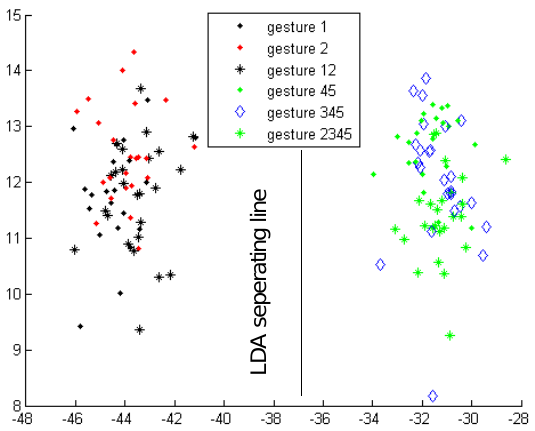
Figure 13. Classifier 4 in the second-level of the first